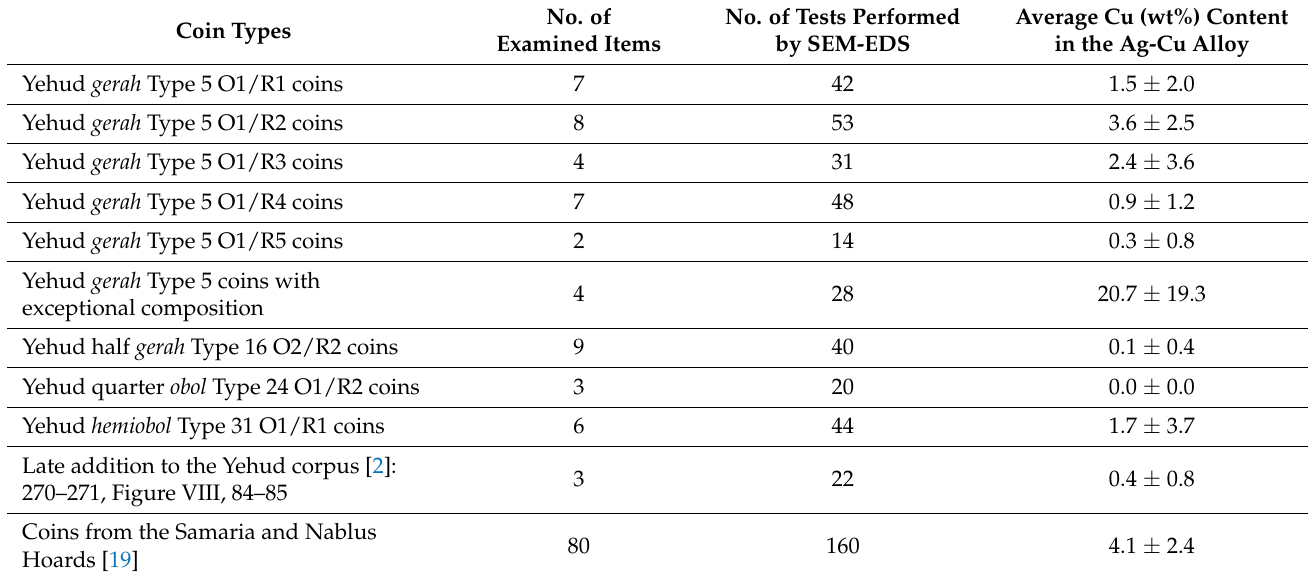
Table 1. The average alloy composition (Cu wt% content) of the different Yehud Types 5, 16, 24, and 31, the late addition Yehud coins, and the Samaria and Nablus Hoards coins, according to SEM- EDS